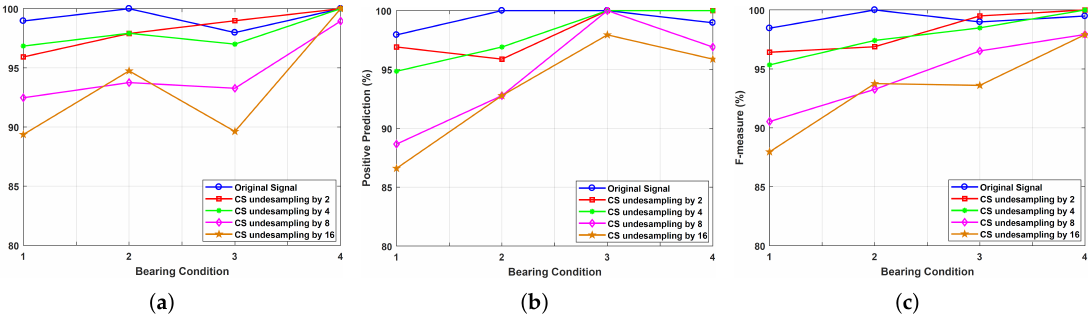
Figure 11. Comparison of classifier performance using: ( a ) sensitivity, ( b ) positive-prediction, and ( c ) F-measure, in classifying the features obtained from original signal and from compressive measurements with varying undersampling ratios for different bearing